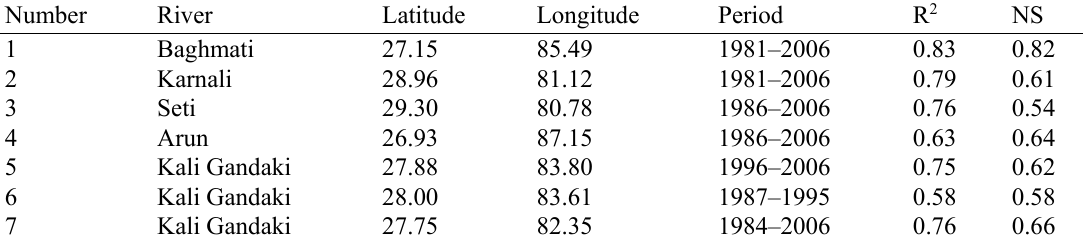
Fig. 1 Modelled sub-catchments of GRB and the streamflow gauges. Table 2 Model performance indicators for seven locations in